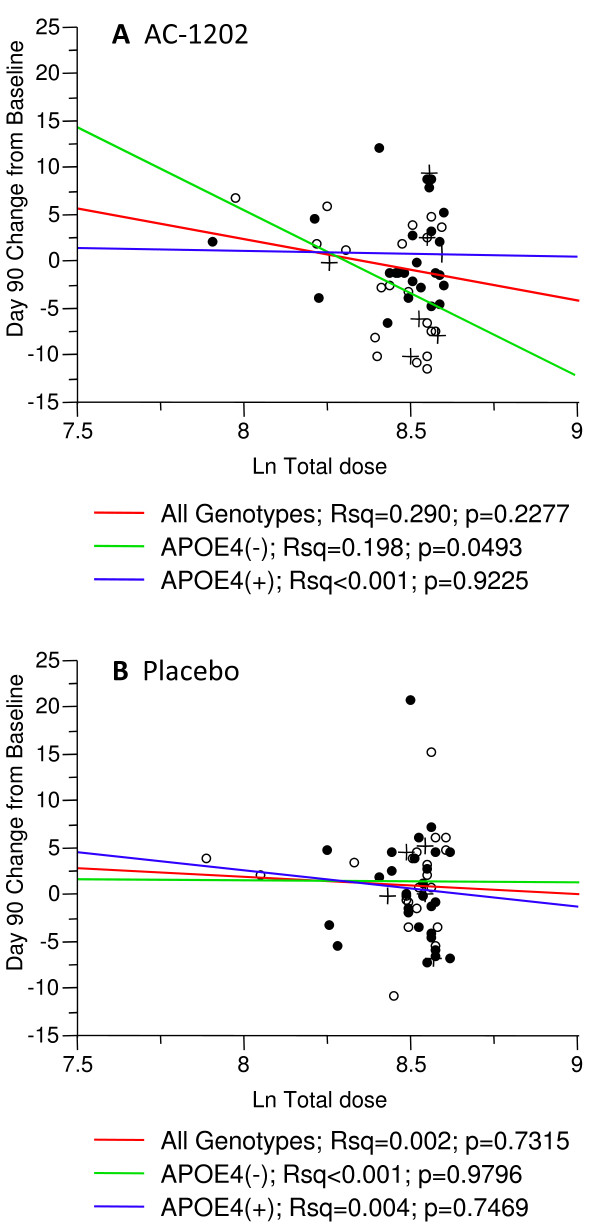
Linear fit of change from Baseline at Day 90 in ADAS-Cog score and log transformed total dosage stratified by APOE4 carriage status. Only reported ADAS-Cog scores were used; no data was imputed. Solid circles represent APOE4(+) subjects, open circles represent APOE4(-) subjects. Crosses represent non-dosage compliant subjects. Red line indicates linear fit for all genotypes, green line for APOE4(-) subjects, and blue line for APOE4(+) subjects. A) Among subjects taking AC-1202, a significant correlation was found in APOE4(-) subjects in change from Baseline at Day 90 in ADAS-Cog score and log transformed total dosage. B) Among subjects taking Placebo, no significant correlations were found in change from Baseline at Day 90 in ADAS-Cog score and log transformed total dosage.